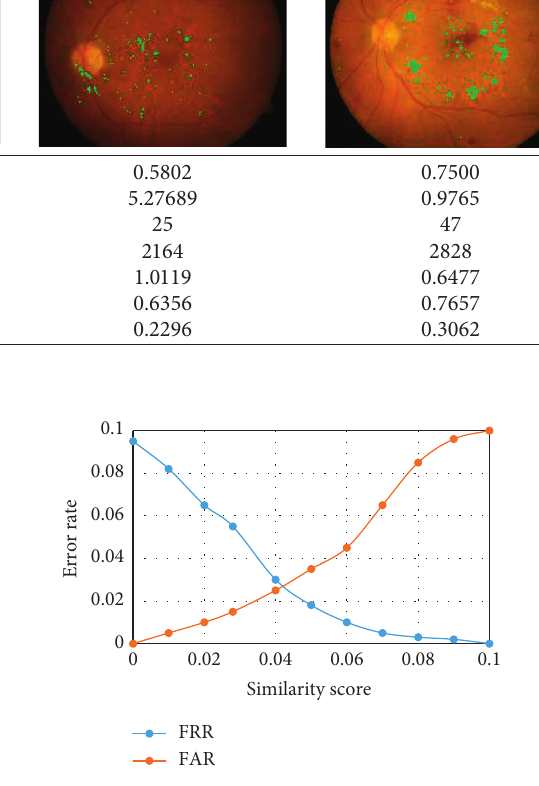
Figure 9: Equal error rate for IDRiD.